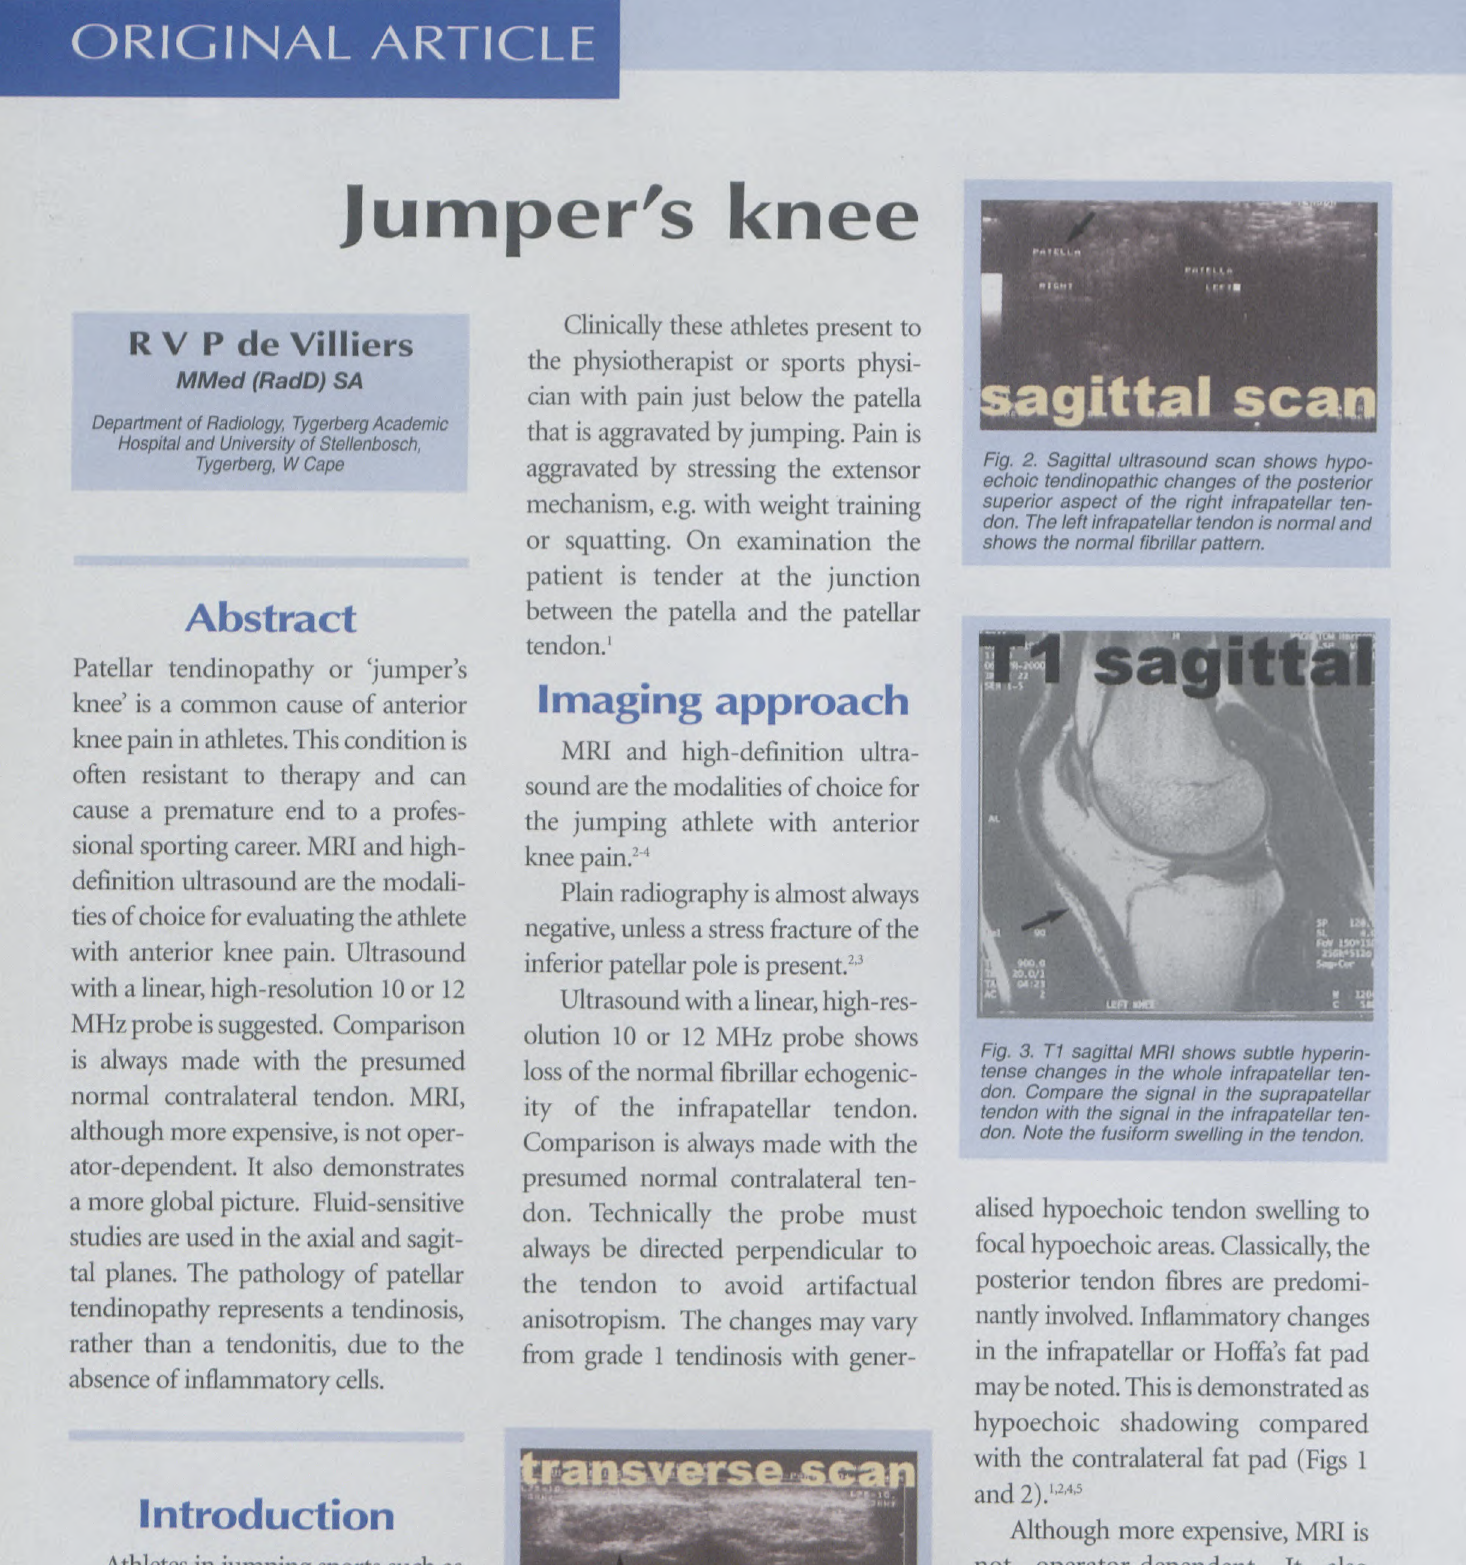
Fig. 1. Transverse ultrasound scan of infra- patellar tendon. Right tendon shows hypoechoic tendinopathic changes.